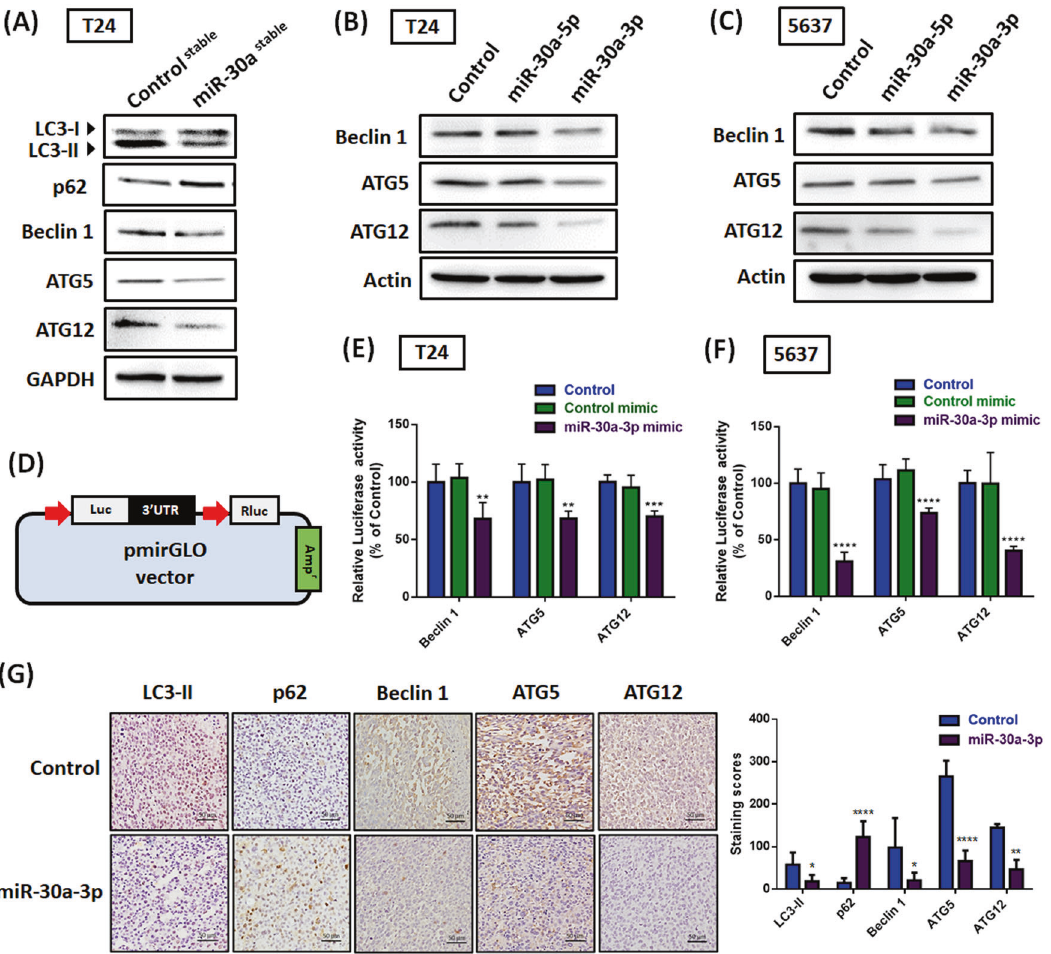
Fig. 5 Hsa-miR-30a-3p inhibits ATG5, ATG12, and Beclin 1 expression. A LC3-II, p62, ATG5/12, and Beclin 1 protein expression in stable cells were measured through western blot assay ( N = 3). B , C Transfection of BC cells (T24 and 5637) with the control mimic (25 nM), miR-30a-5p mimic (25 nM), or miR-30a-3p mimic (25 nM) for 24 h; the levels of ATG5/12 and Beclin 1 protein expression were analyzed through western blot assay ( N = 3). D Schematic 3 ′ -UTR representation of human ATG5/12 and Beclin 1 containing the hsa-miR-30a-3p-binding site in pmiR- GLO luciferase vector. E , F The BC cells were cotransfected with indicated-3 ′ -UTR plasmid (1 μ g/ μ L) and hsa-miR-30a-3p mimic (25 nM) for 24 h; relative luciferase/Renilla activities were then measured ( N = 3). G Histologic sections of murine tumor were immunostained with LC3-II, p62, ATG5/12, and Beclin 1 ( N = 3). All data are expressed as means ± SDs in triplicate samples. * P < 0.05, ** P < 0.01, *** P < 0.001, and **** P < 0.0001 relative to the control